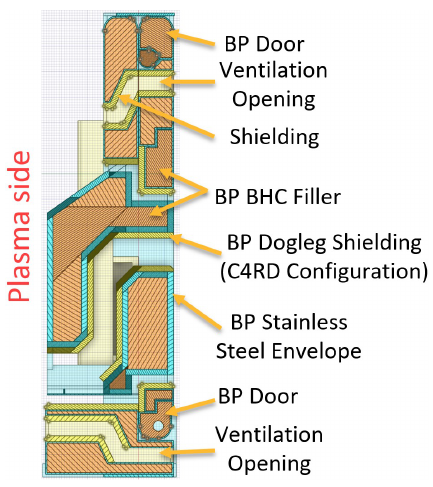
Figure 4. BP components.